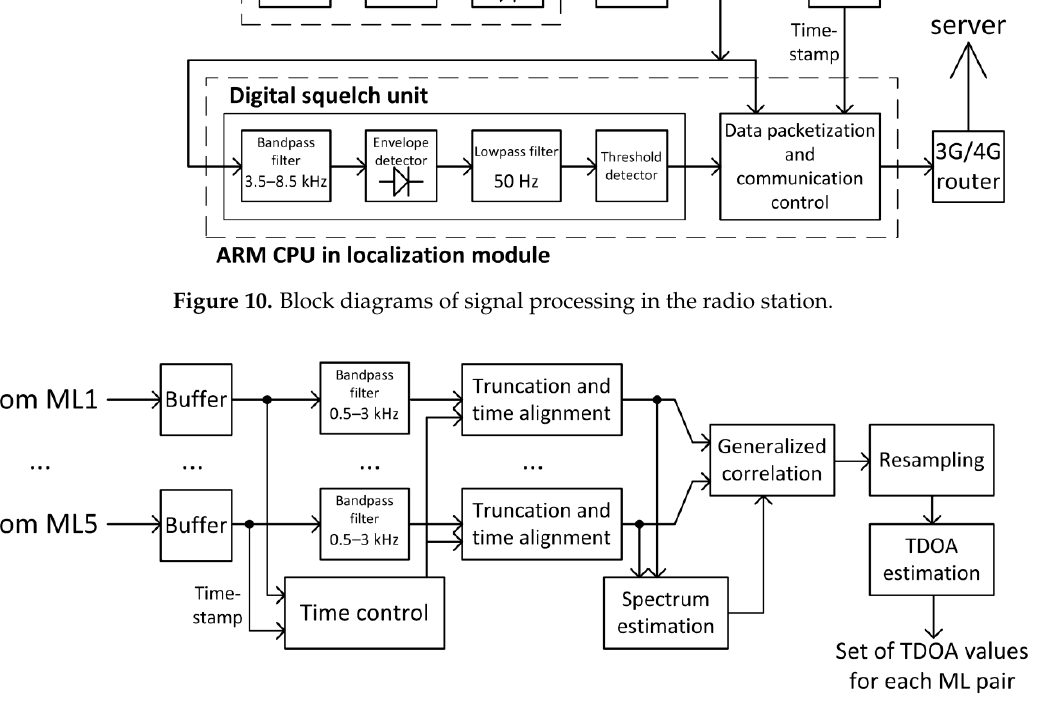
Figure 11. Block diagrams of signal processing in the central server.